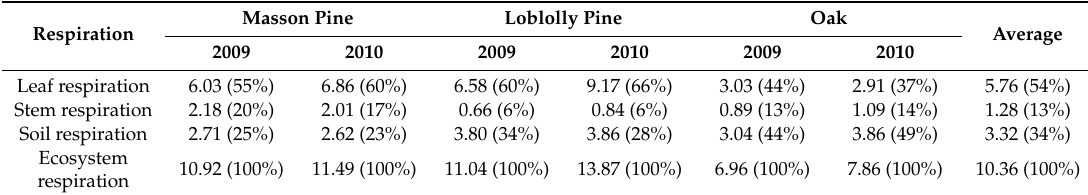
Table 4. Ecosystem respiration, ground-based component respiration ( µ mol m − 2 s − 1 ) and percentage (%) in three stands during the growing season when temperatures peak.